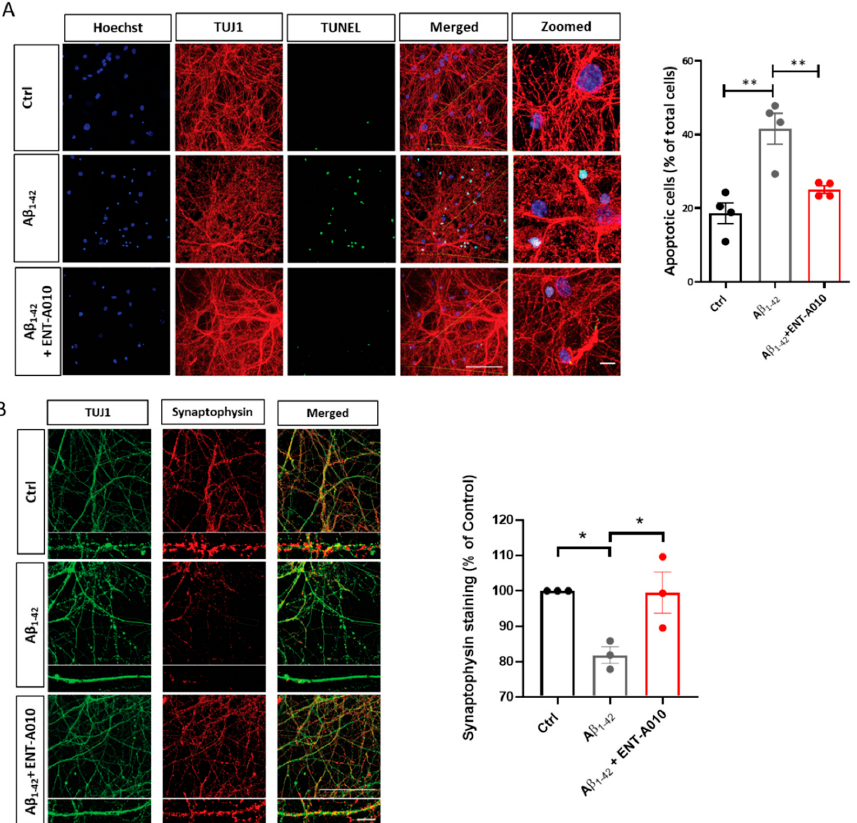
Figure 5. ENT-A010 protected primary hippocampal neurons against oligomeric A β toxicity. ( A ) Primary hippocampal neurons were treated for 48 h with 5 μ M oligomeric A β and ENT-A010 (500 nM, freshly added every 24 h) or control vehicle and stained for TUJ1 (red), with TUNEL (green) or Hoechst (blue). The quantification shows the number of TUNEL + (apoptotic) cells as % of the total number of cells. ( B ) Photomicrographs of primary hippocampal neurons, treated for 4 h with 5 μ M oligomeric A β and ENT-A010 (500 nM) and immunostained against TUJ1 and Synaptophysin. The Synaptophysin- and TUJ1-positive areas were quantified and the ratio (Synaptophysin + area /TUJ1 + area) was calculated and normalized in each experiment to the control. Ten to twelve images were acquired per sample. Scale bar: 100 μ m (applies to all non-zoomed photos), and 10 μ m (applies to all zoomed-in photos). Data are shown as mean ± SEM, n = 3–4, *: p < 0.05, **: p < 0.01.